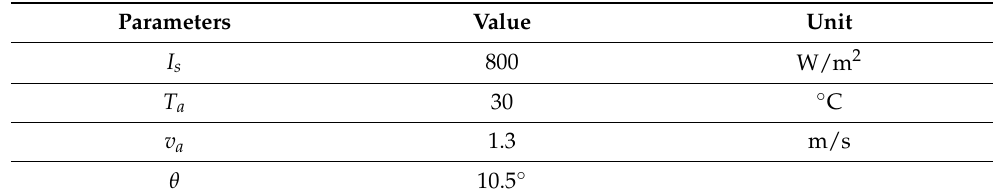
Table 3. Values of reference parameters.